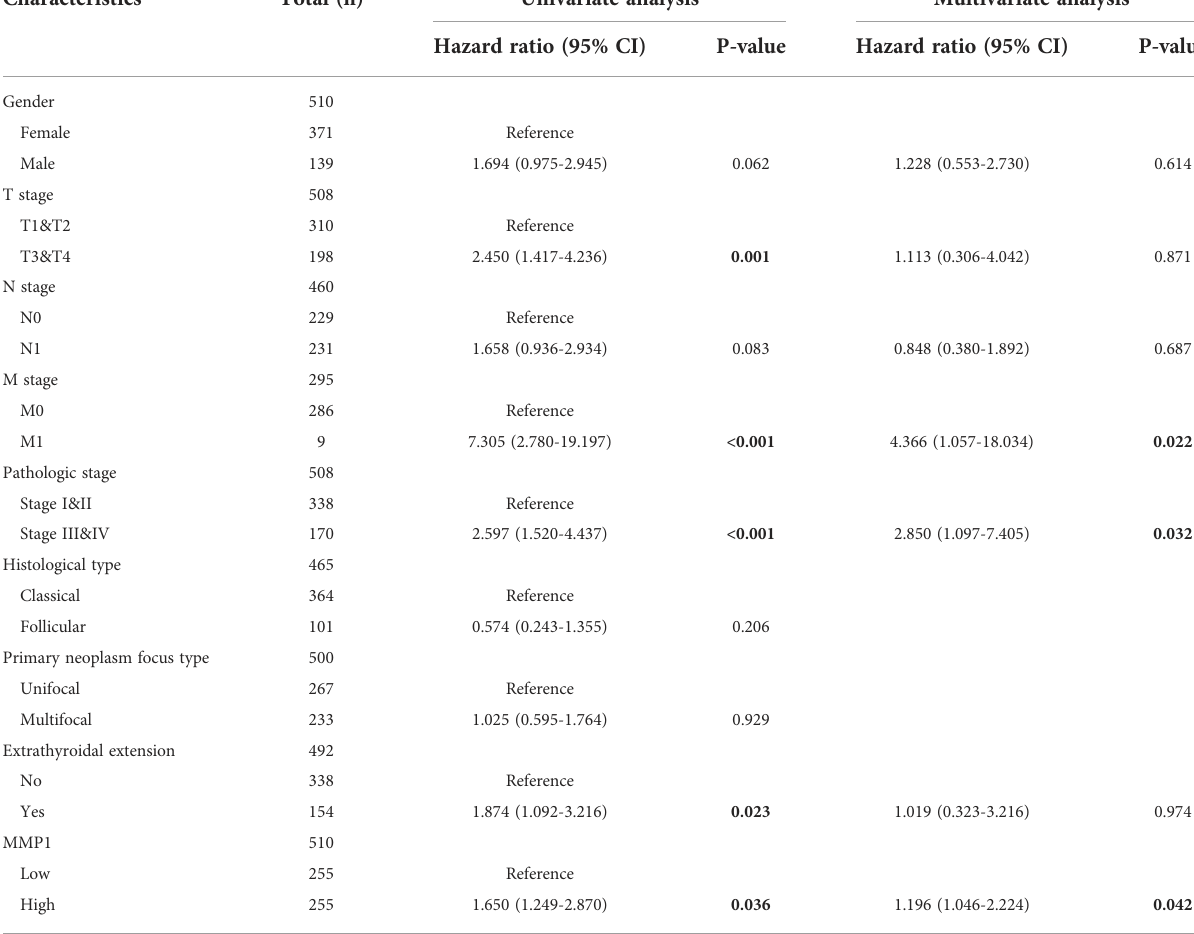
TABLE 2 Risk factors for DFI of PTC patients from the TCGA